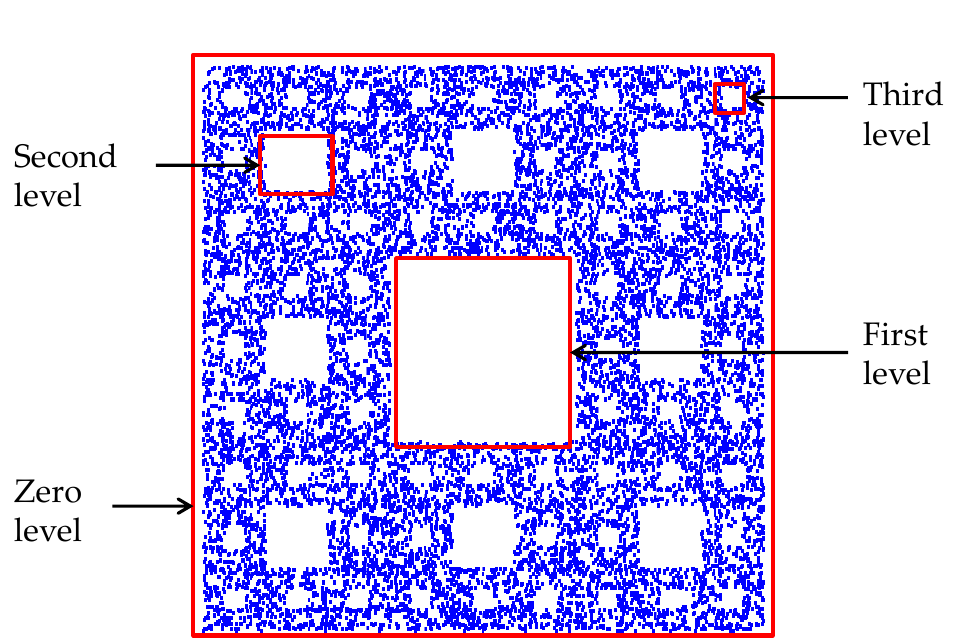
Figure 6. Sierpinski Carpet and its self-similarity nature.